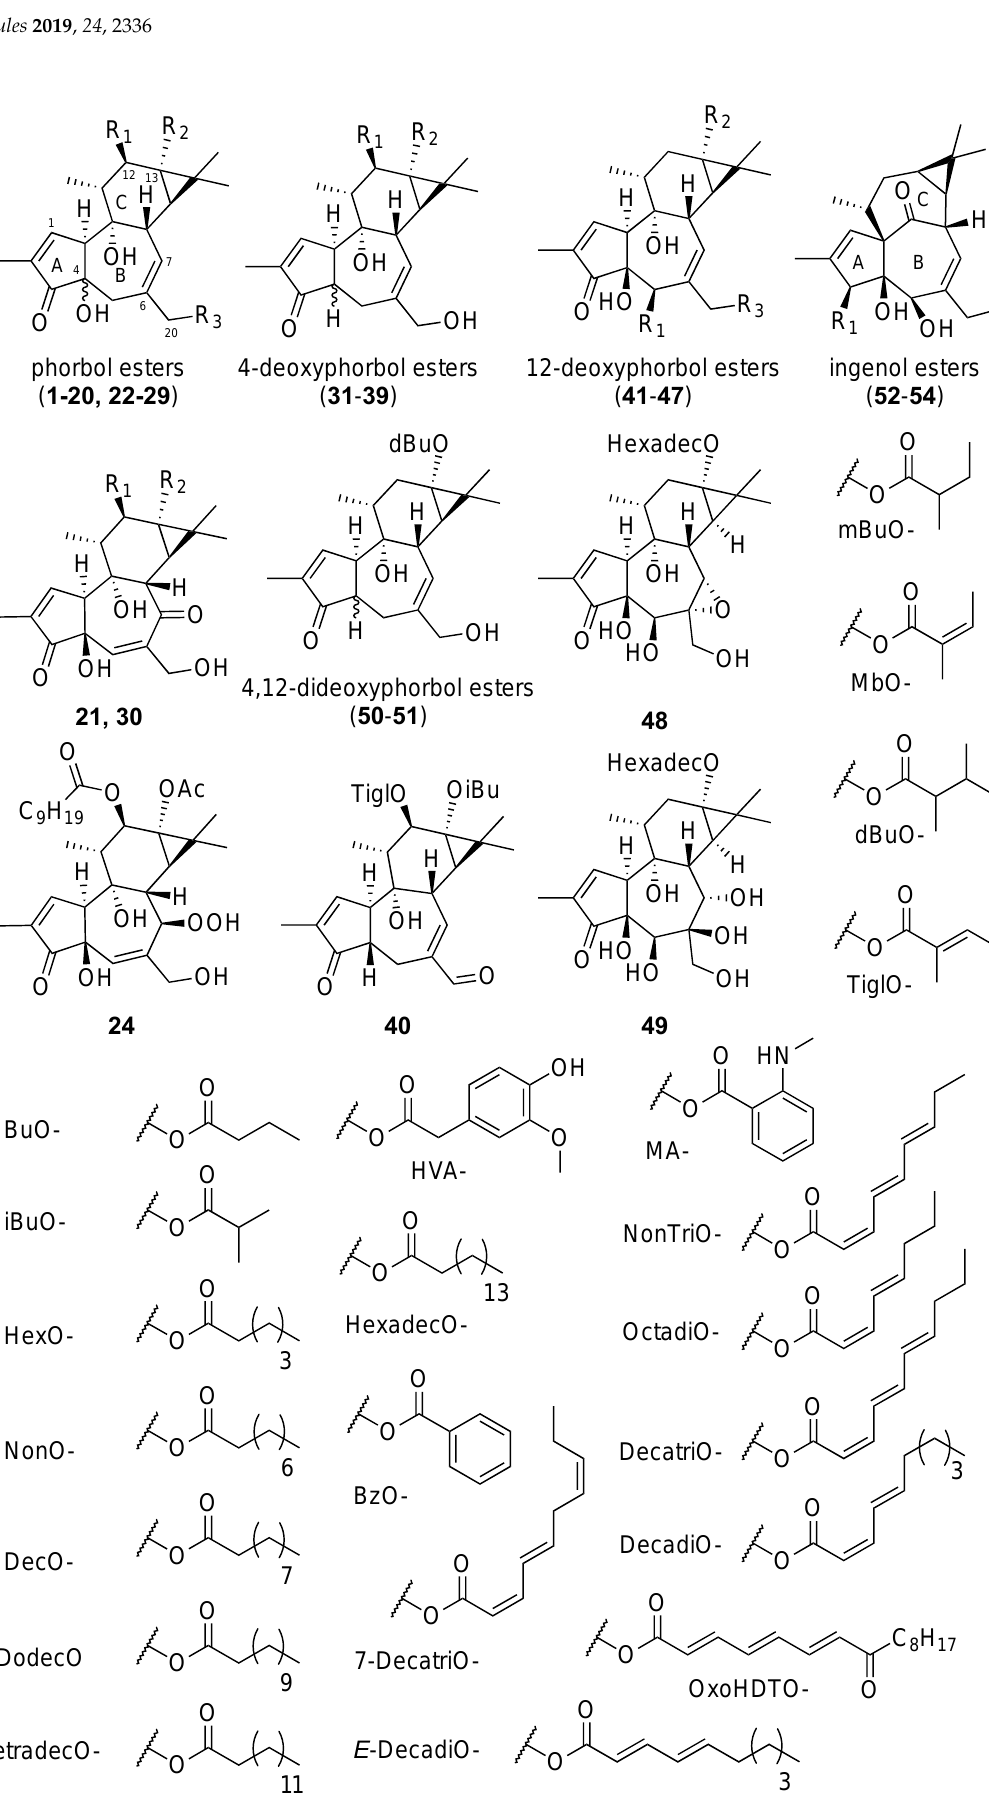
Figure 1. Structures of tiglianes 1 – 51 and ingenanes 52 – 54.